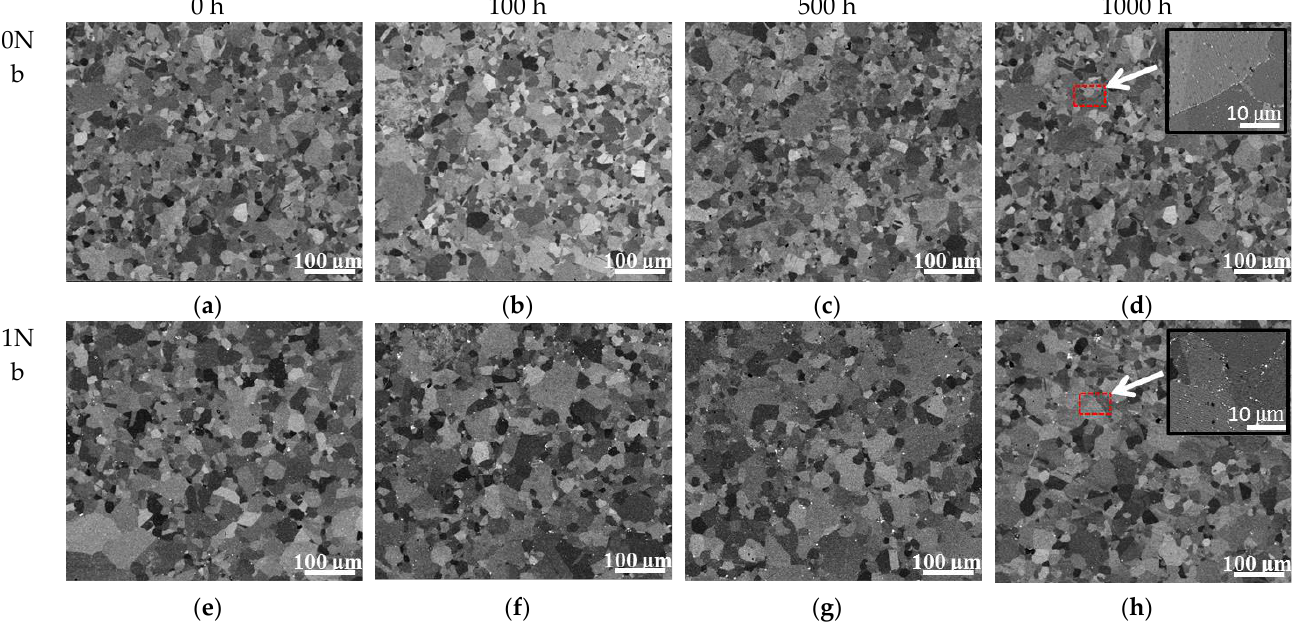
Figure 4. ( a – h ) Backscatter electron (BSE) images of the 0Nb and 1Nb alloys during long-term exposure at 800 °C.